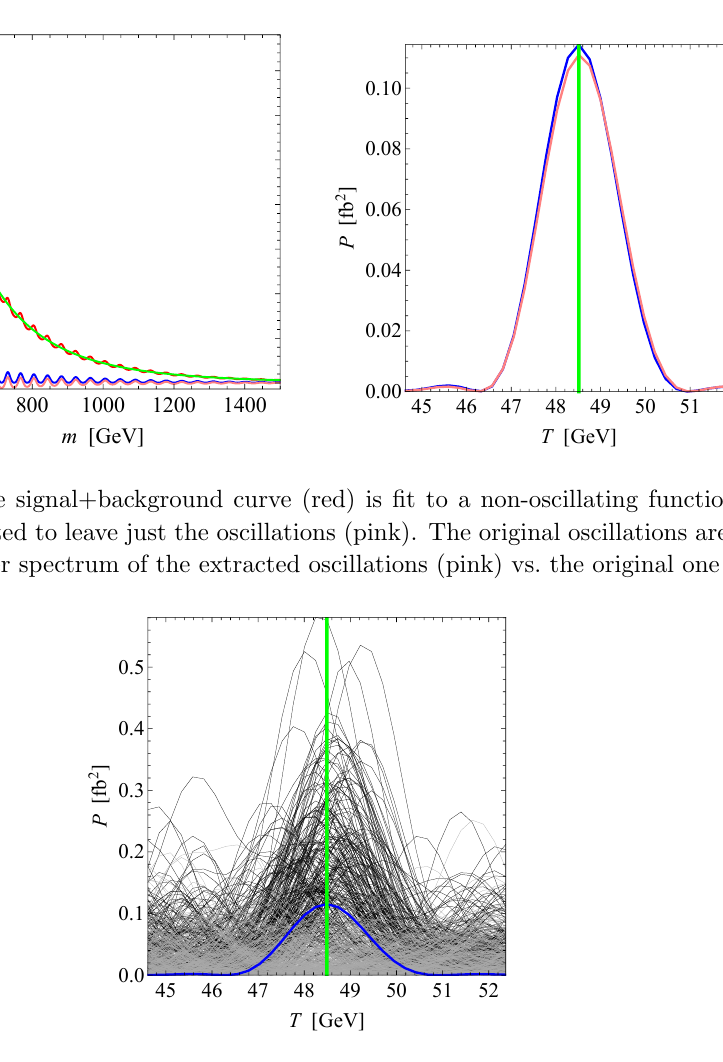
Figure 17 . Power spectra for multiple realizations of the signal+background (black lines) compared with the input signal (blue line), and multiple realizations of the background in the absence of any signal (gray